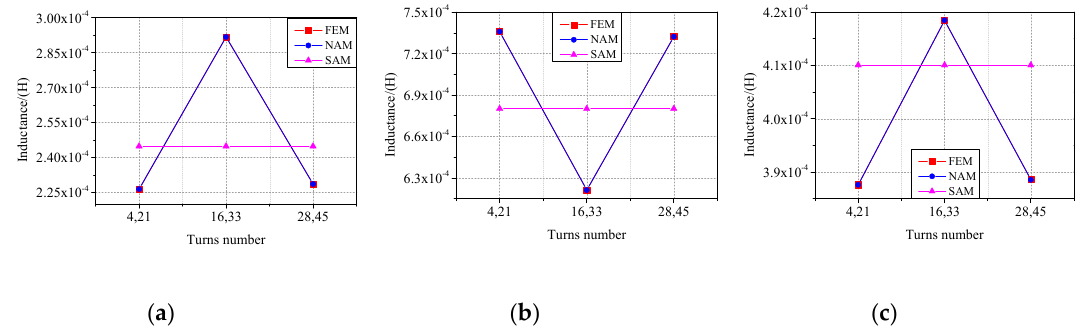
Figure 15. The inductances of the faulty coil when there are 10 turns shorted in different layers: ( a ) self-inductance in faulty part; ( b ) self-inductance in healthy part; ( c ) mutual inductance.